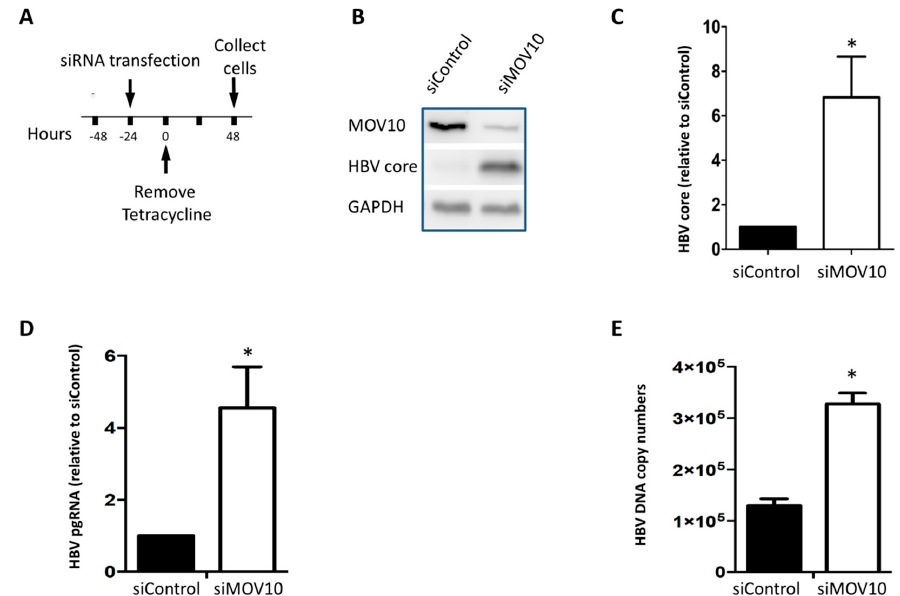
Figure 1. Down-regulation of MOV10 (Moloney Leukemia Virus 10) enhances Hepatitis B